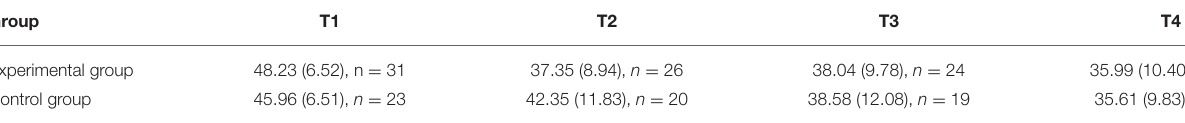
TABLE 3 | Descriptive results.